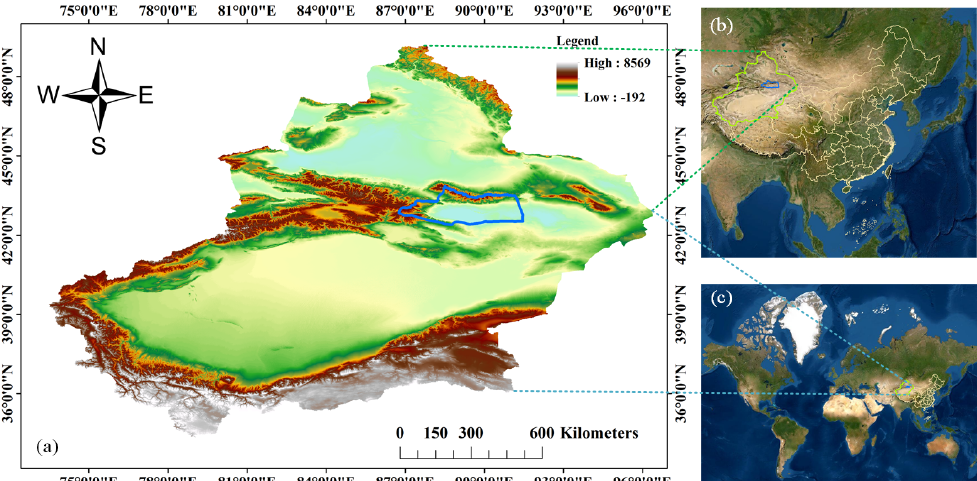
Figure 2. The blue box indicates the Turpan Basin, which is the study area of this paper. ( a ) Map showing the geographical location of the study area in the Xinjiang Uyghur Autonomous Region. The background consists of SRTM DEM data with a resolution of 90 m. ( b ) Xinjiang’s location in China, the base map is World-Imagery in ArcGIS. ( c ) Xinjiang’s location in the world, the base map is World-Imagery in